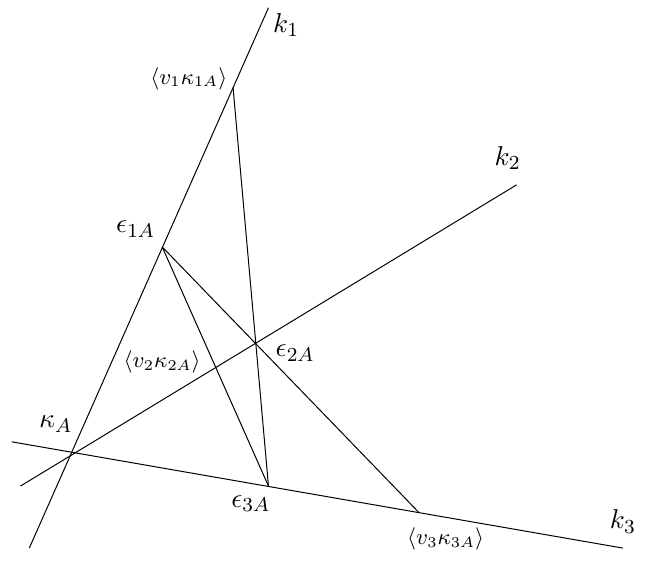
Figure 1 . Each k i corresponds to a line in the projective spin space spanned by (cid:20) iaA . The lines lie in a common two-plane orthogonal to (cid:20) A and are concurrent meeting at (cid:20) A de(cid:12)ned by (5.4). Thus the line k 1 joins (cid:15) 1 A and (cid:20) A and so on. The polarized scattering equations give 3 further lines, e.g. with E 1 A giving the line joining (cid:15) 2 A and (cid:15) 3 A and intersecting k 1 at h v 1 (cid:20) 1 A i